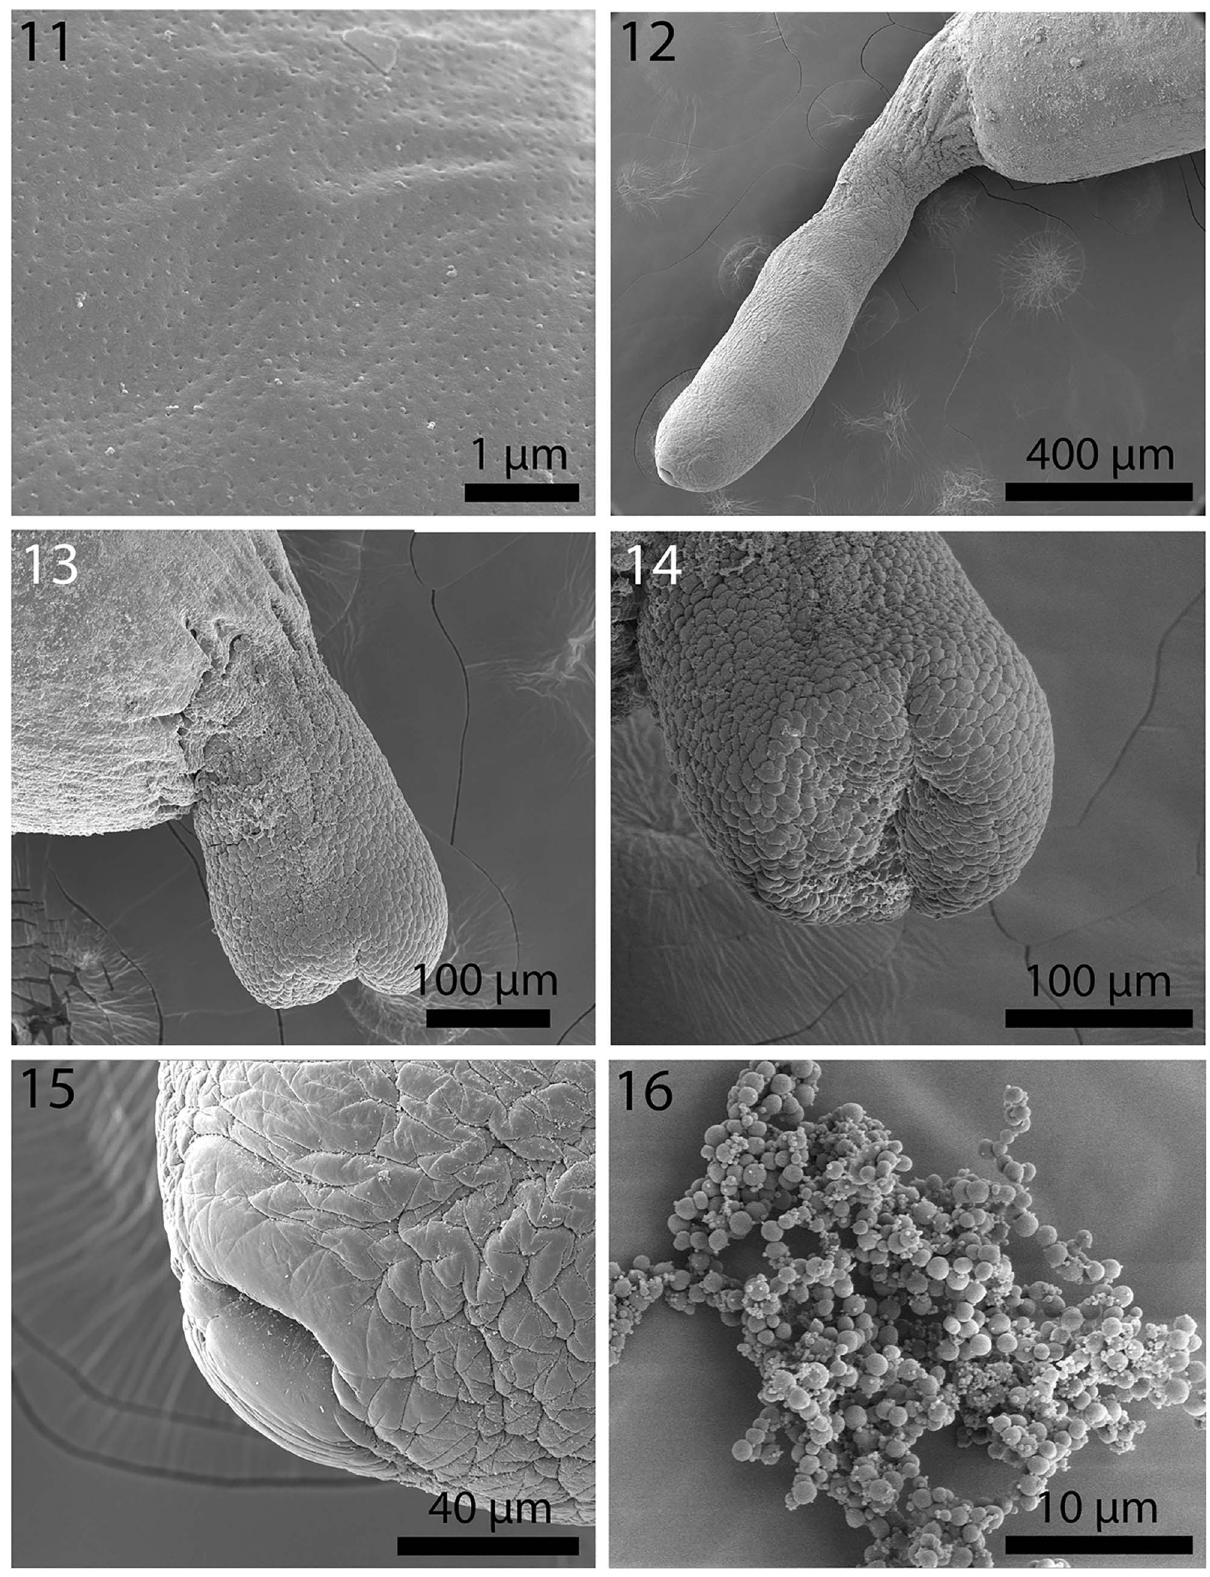
Figures 11 – 16. SEM of cystacanths of Pro fi licollis altmani from Emerita analoga on the Peruvian coastline, Lima. 11. Micropores from the mid-trunk region. 12. A fully extended tail. 13. Lateral view of a partially retracted tail. 14. Posterior view of the partially retracted tail showing invagination point and the coarse corrugated texture of the cuticular surface. 15. Genital ori fi ce of a female gonopore at the posterior end of a fully extended tail. Note the thick un-corrugated lips. 16. A cluster of developing eggs in a female